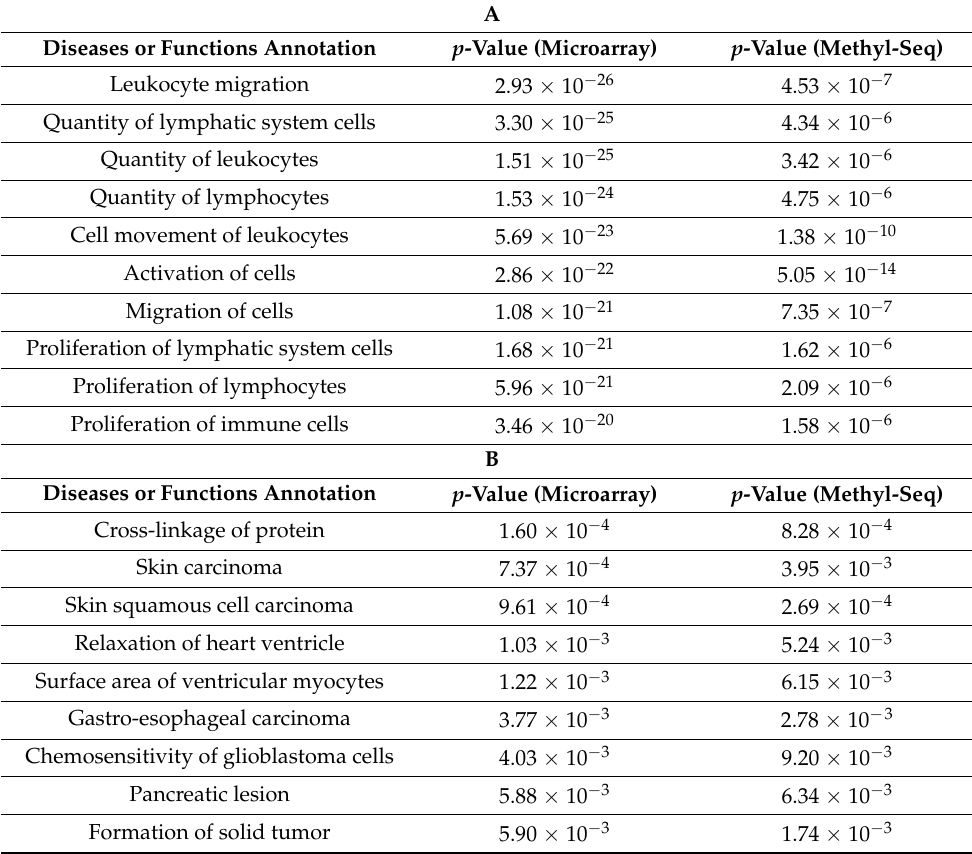
Table 3. Diseases or Functions Annotations in common between methylation-profiling microarray data and targeted methylation sequencing data (data from IPA Core